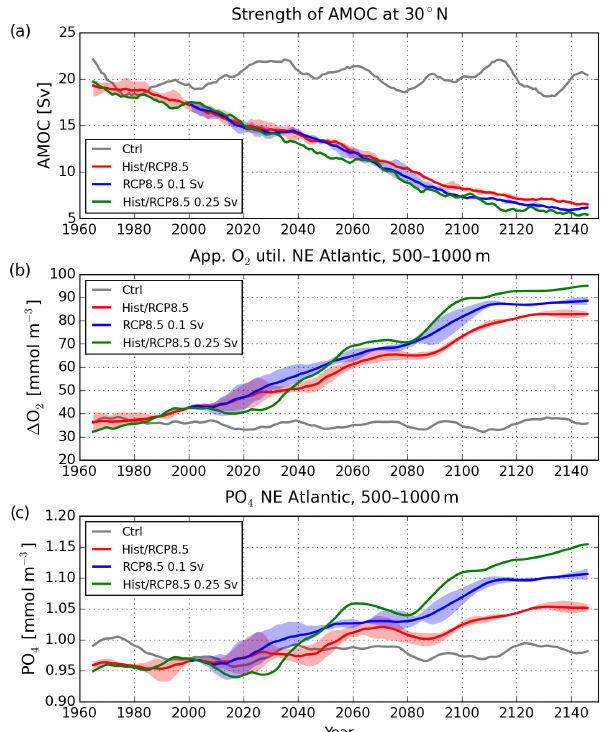
Figure 6. Strength of Atlantic meridional overturning circula- tion (a) , represented by the vertical maximum of the annual mean stream function of the zonally integrated meridional transport at 30 ◦ N. Annual apparent oxygen utilization (b) and phosphate con- centration (c) in the NE Atlantic (45–62 ◦ N, 15–28 ◦ W) at 500– 1000m depth. Solid: control run C0 (gray), the ensemble means of experiments E0 (red) and E010 (blue), and a single realization of E025 (green). Shaded areas: ensemble spreads.